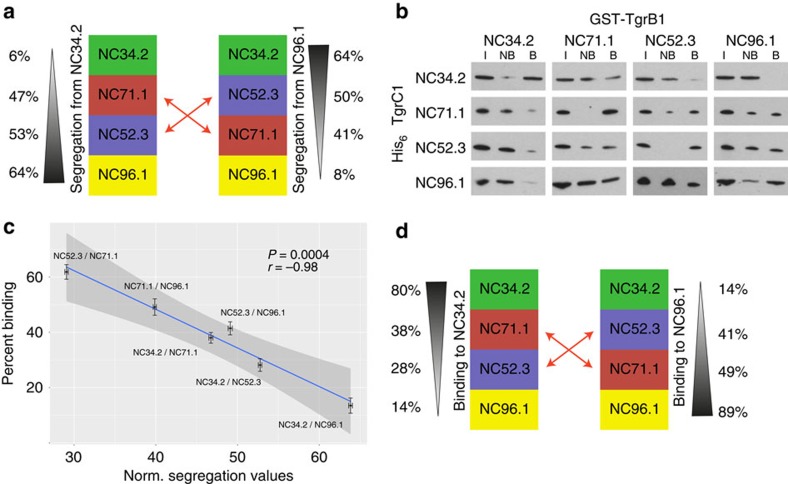
Segregation between strains can be predicted by TgrB1/TgrC1 binding.(a) Strains exhibit non-transitive segregation behaviour. Segregation values between the four strains are not transitive. Numbers on the left show segregation values of mixes containing NC34.2 ordered from top to bottom and numbers on the right show segregation values of mixes containing NC96.1 ordered from bottom to top. Black triangles depict the degree of segregation. Red arrows depict the non-transitive swap of strains NC52.3 and NC71.1. Mean segregation values of all pairings within each hierarchy are significantly different (one-way analysis of variance (ANOVA); P<2.2 × 10−16). (b) Immunoprecipitation of bacterially expressed His6–TgrC1 and GST–TgrB1 from four different strains. The highest binding was observed between proteins from the same strain. The weakest binding was observed between Tgr proteins from NC34.2 and NC96.1. Varying levels of protein binding were observed between the Tgr proteins from other strains (I=input protein, NB=not bound protein and B=bound protein). (c) Scatterplot of binding and segregation values. For each pairwise strain comparison, normalized segregation values were plotted against percent binding. A minimum of six biological replicates were performed for each protein pairing. Y axis error bars depict s.e. of the mean percentage of bound protein in each fraction of the biological replicates, quantified by measuring band intensities on western blots using ImageJ80. X axis error bars depict s.e. of the mean normalized segregation value derived from 1000 bootstrapped samples (see methods). Blue line depicts highly negative and significant (Pearson's product moment correlation: r=−0.98, P=0.0005) correlation between segregation values and protein binding for mixes of four chosen strains (gray shading: the 99% confidence envelope). Self-mixes are excluded. (d) Strength of binding predicts non-transitive segregation behaviour. Binding is not transitive. Numbers show binding of the Tgr proteins. Black triangles depict the strength of binding. Red arrows depict the non-transitive swap of strains NC52.3 and NC71.1. This pattern mirrors the non-transitive behaviour of the segregation values (shown in panel a). Mean binding values between each pairing in the hierarchy are significantly different (one-way ANOVA; P<2.2 × 10−16 using adjusted P value 0.05).